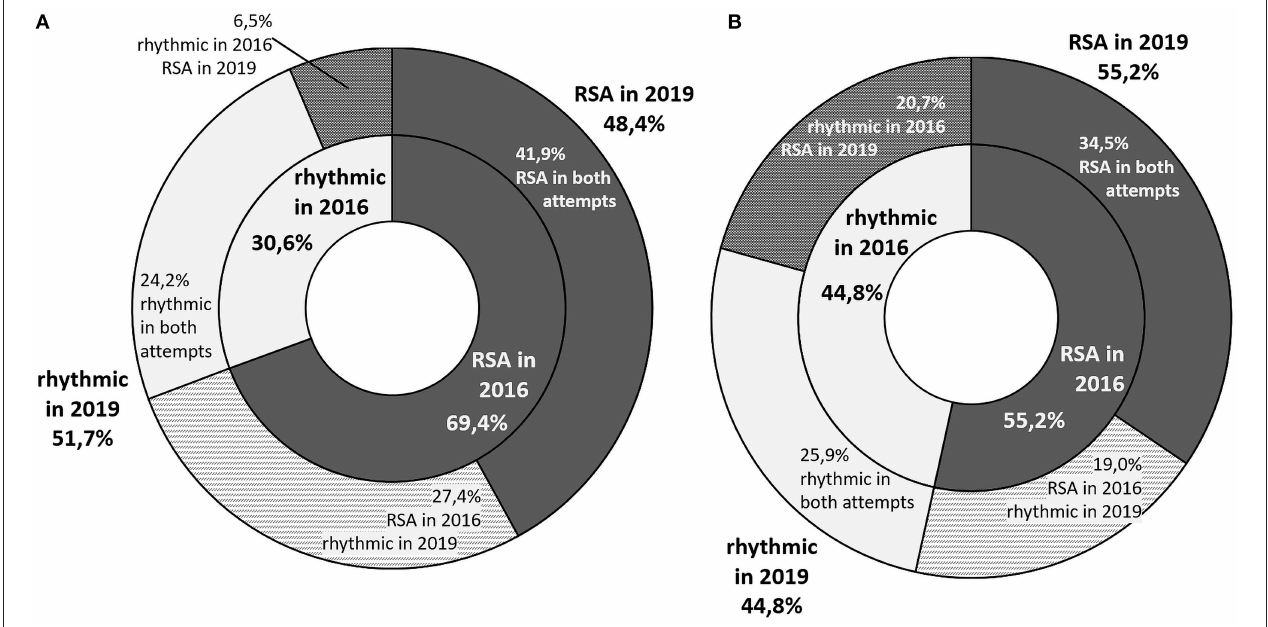
FIGURE 1 | A graphic representation of the proportion of students with respiratory sinus arrhythmia in both visits. The inner ring represents the health status in year 2016, and the outer ring - in 2019. The participants whose status changed across time are represented with intermediate colors in the outer ring (A) graph stands for boys and (B) one for